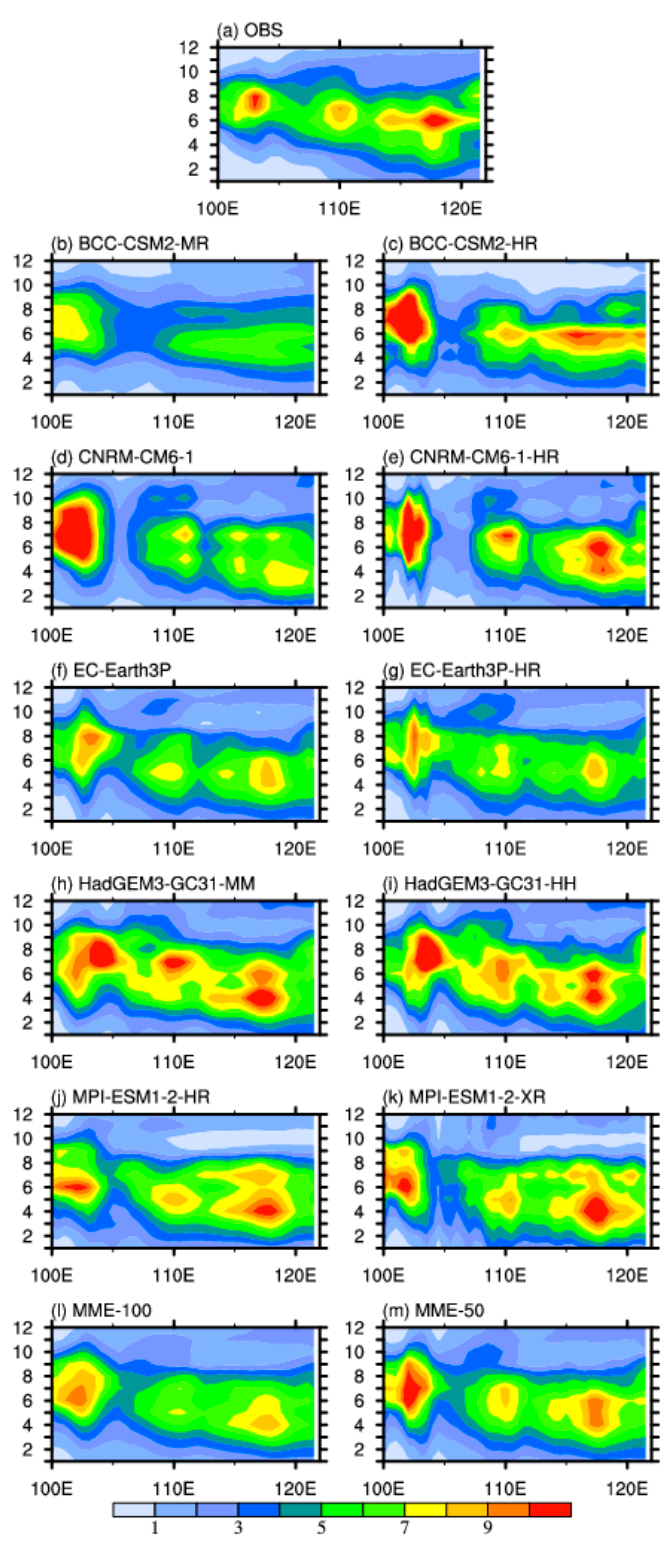
Figure 5. Longitude-month cross-sections of the climatological mean precipitation (mm day − 1 ) averaged along 29 ◦ –30 ◦ N in the ( a ) observation, ( b – k ) models, ( l ) MME-100, and ( m ) MME-50.